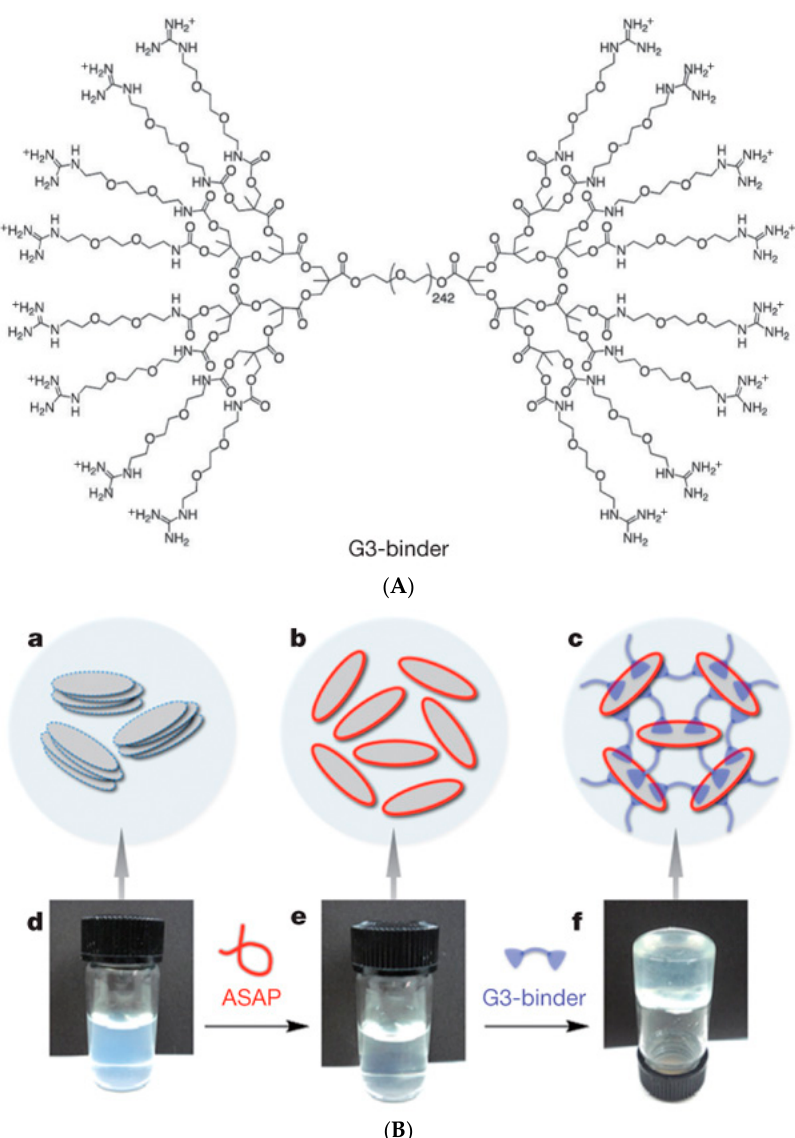
Figure 13. ( A ) Structure of guanidine-functionalized G3-binder; ( B ) Non-covalent preparation of hydrogels. ( a – c ) Proposed mechanism for hydrogelation. CNSs, entangled with one another ( a ), are dispersed homogeneously by interaction of their positive-charged edge parts with anionic ASAP ( b ). Upon addition of Gn-binder, exfoliated CNSs are crosslinked to develop a 3D network ( c ). ( d – f ) Optical images of an aqueous suspension of CNSs ( d ), an aqueous dispersion of CNSs and ASAP ( e ) and a physical gel upon the addition of G3-binder to the dispersion ( f ). Reprinted with permission from [148]. Copyright 2016 Nature Publishing Group.